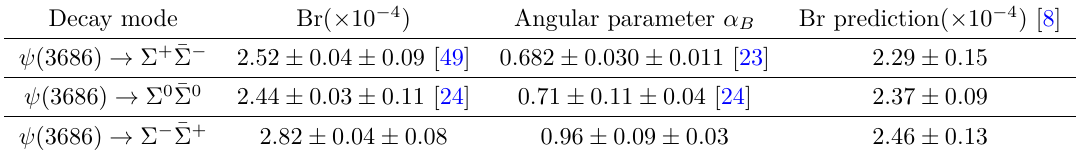
Table 4 . Summary of the measured angular parameters and branching fractions of ψ (3686) → Σ + ¯Σ − , Σ 0 ¯Σ 0 , and Σ − ¯Σ + , together with theoretical predictions of the branching